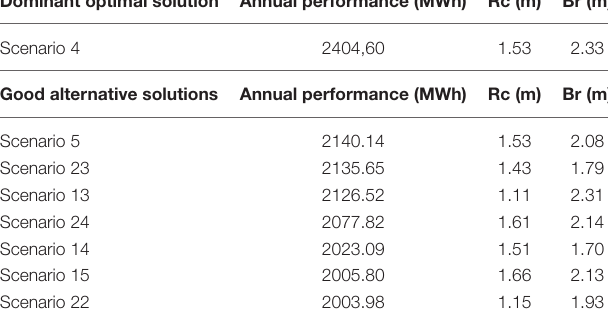
TABLE 3 | OBREC device solutions based on maximum annual energy performance criterion.